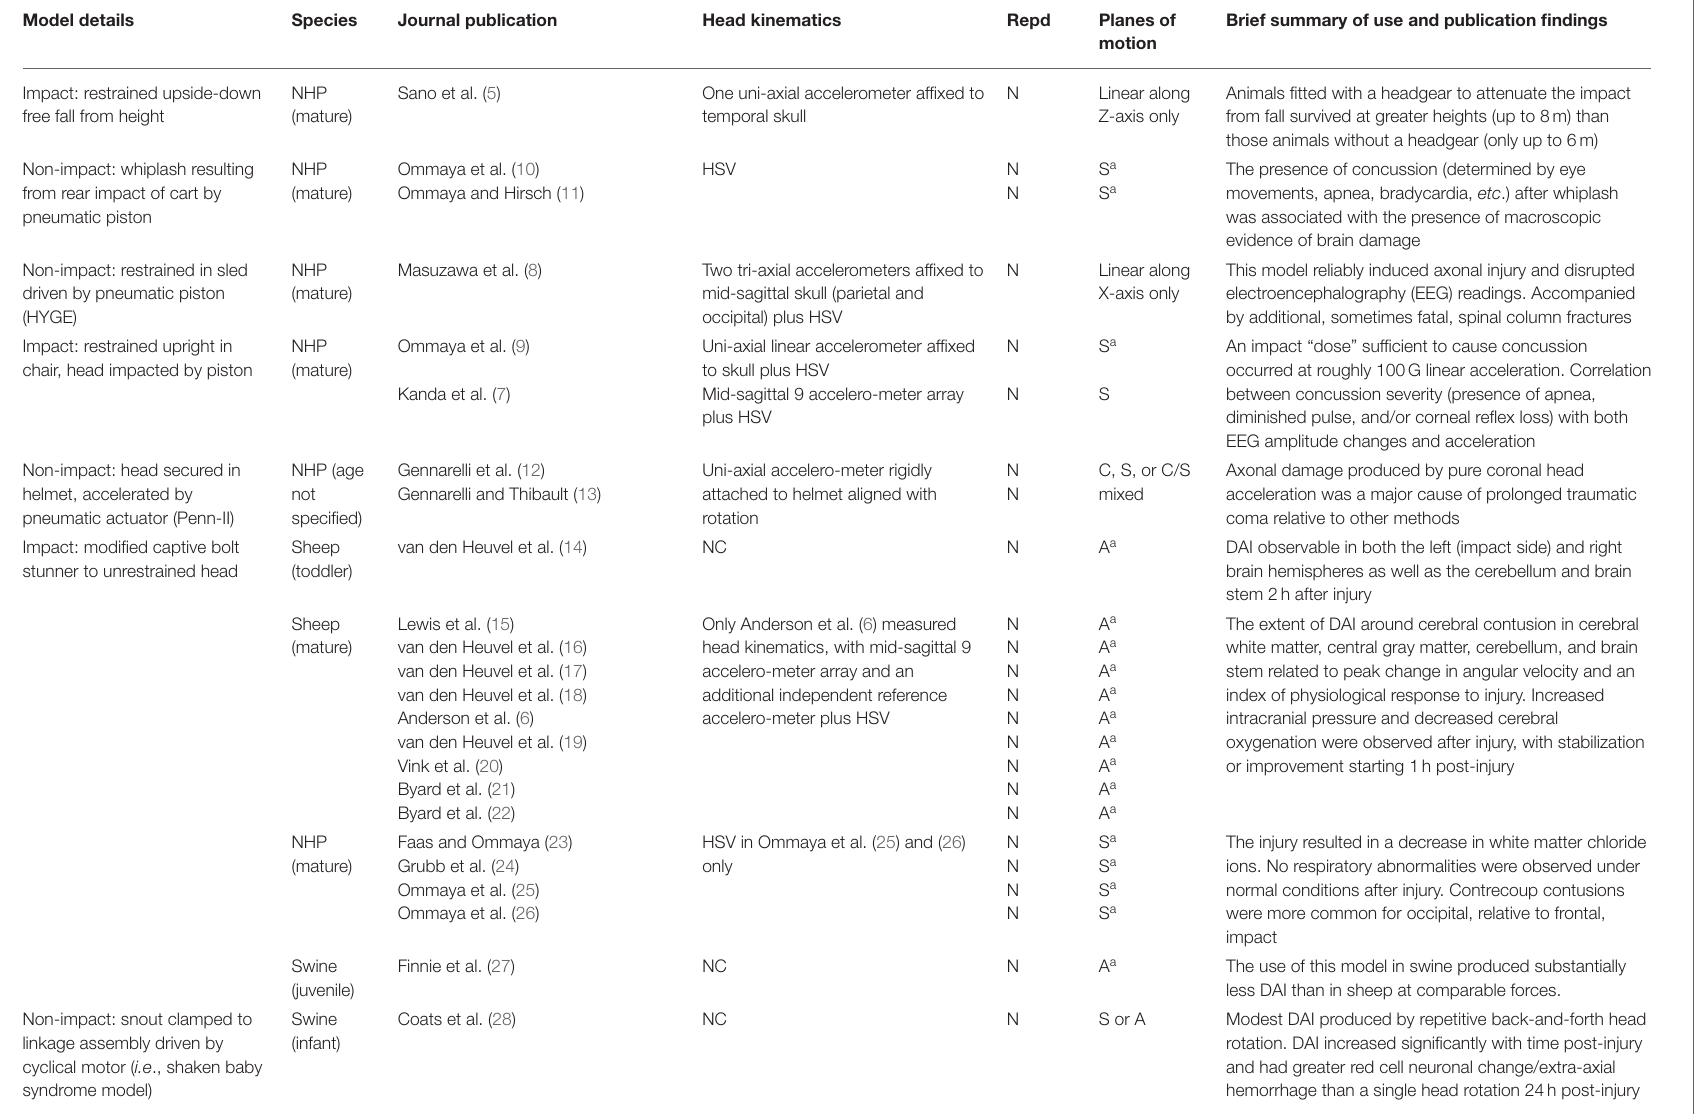
TABLE 1 | In vivo models of non-invasive diffuse axonal